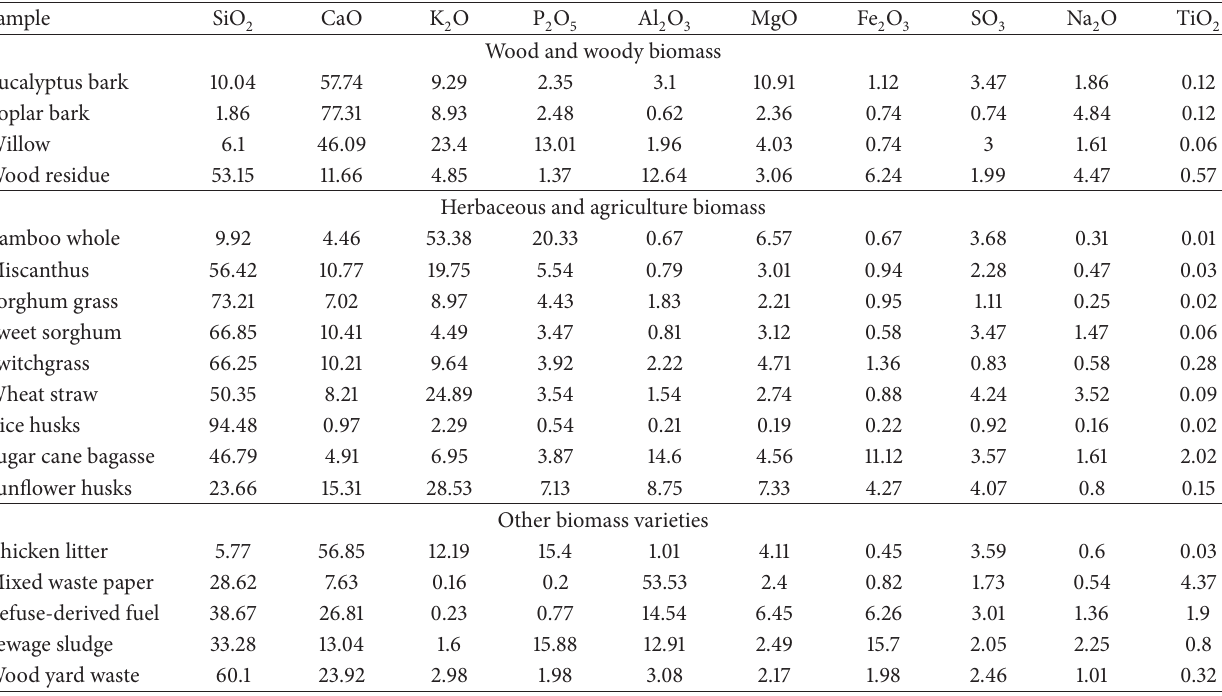
Table 5: Elemental ash composition of different biomass.